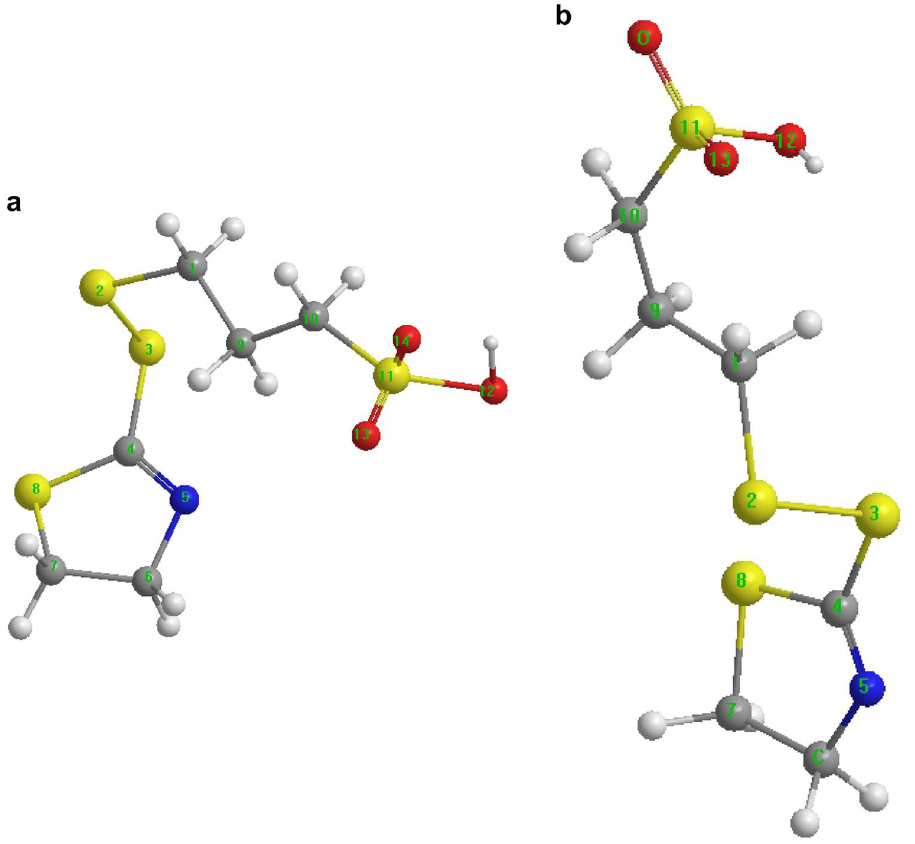
Figure 7. Molecular configuration of SH110 from MD simulations. ( a ) Initial and ( b ) equilibrium structures ( https:// www. 3ds. com/ produ cts- servi ces/ biovia/ material studio 6.0).